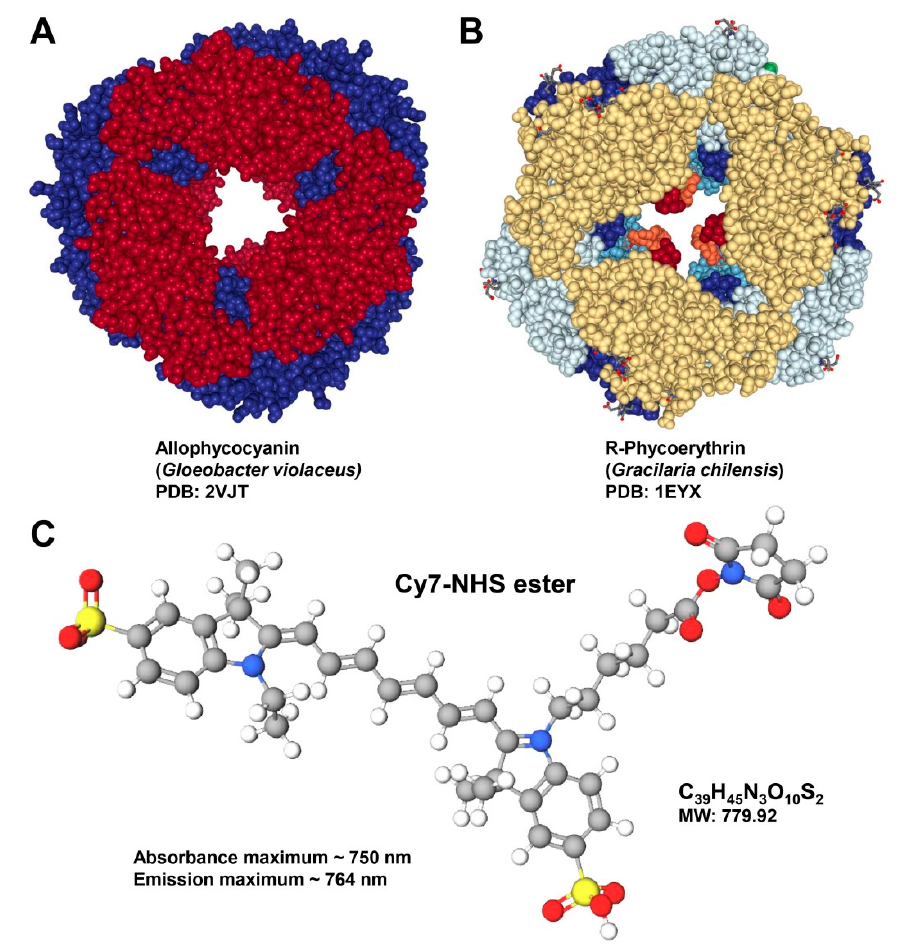
Figure 3. Examples of pigments with fluorescent properties. ( A ) Allophycocyanin (APC) is an accessory, water-soluble pigment of red or blue-green algae that has an absorption maximum at 652 nm and an emission maximum at 657.5 nm. It is composed of a trimer with an ( αβ ) 3 structure and a molecular weight of 105,000 Daltons. The structure of the Allophycocyanin from Gloeobacter violaceus depicted was taken from the RCSB Protein Data Bank (PDB, access. no.: 2VJT) ( B ) Phycoerythrin (PE) is a red protein-pigment occurring in red algae and cryptophytes. It is composed of αβ monomers that can form either trimers ( αβ ) 3 or hexamers ( αβ ) 6 . Depicted is the crystal structure of the light-harvesting R-Phycoerythrin from the red algae Gracilaria chilensis deposited in the PDB (access. no. 1EYX). The structures shown in ( A , B ) were created with the NGL WebGl-based molecular viewer [24]. ( C ) Structure of the cyanine 7- N -hydroxysuccinimide (Cy7-NHS) ester that is a near- infrared fluorescent dye specifically designed for labeling of amines.